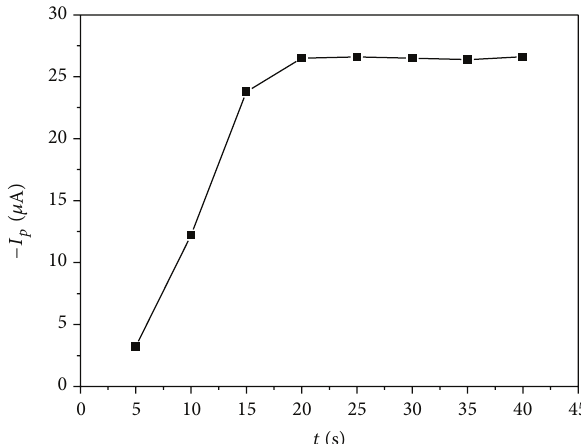
Figure 8: Influence of different accumulation time on peak current of hydroquinone ( 1.0 × 10 −4